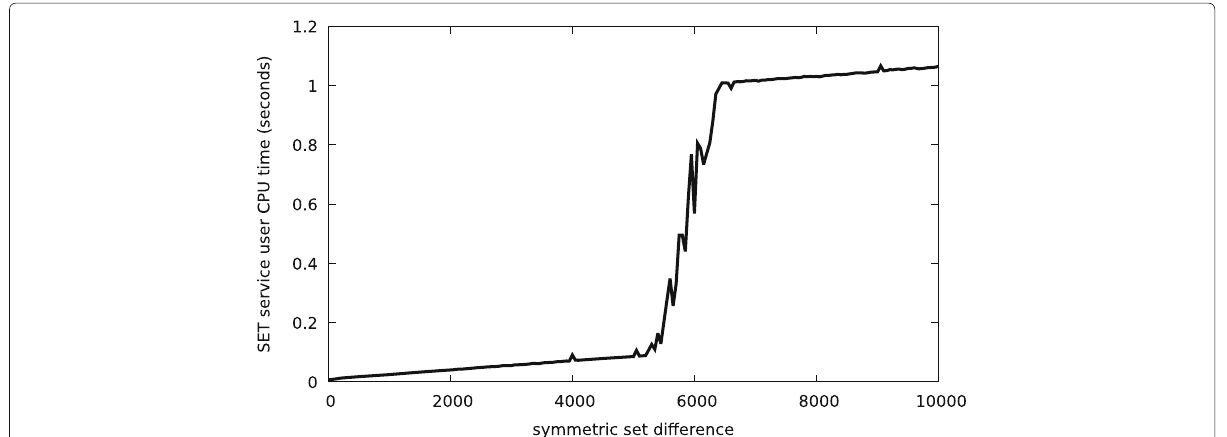
Fig. 3 CPU system time for the SET service in relation to symmetric set difference. Average over 50